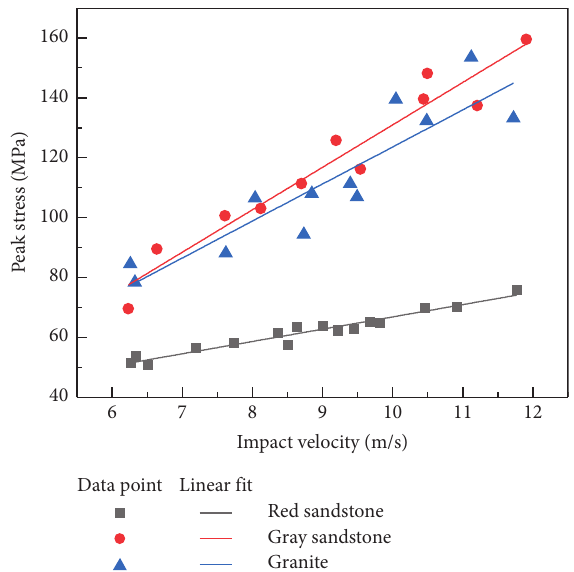
Figure 8: Peak stress-impact velocity diagram.